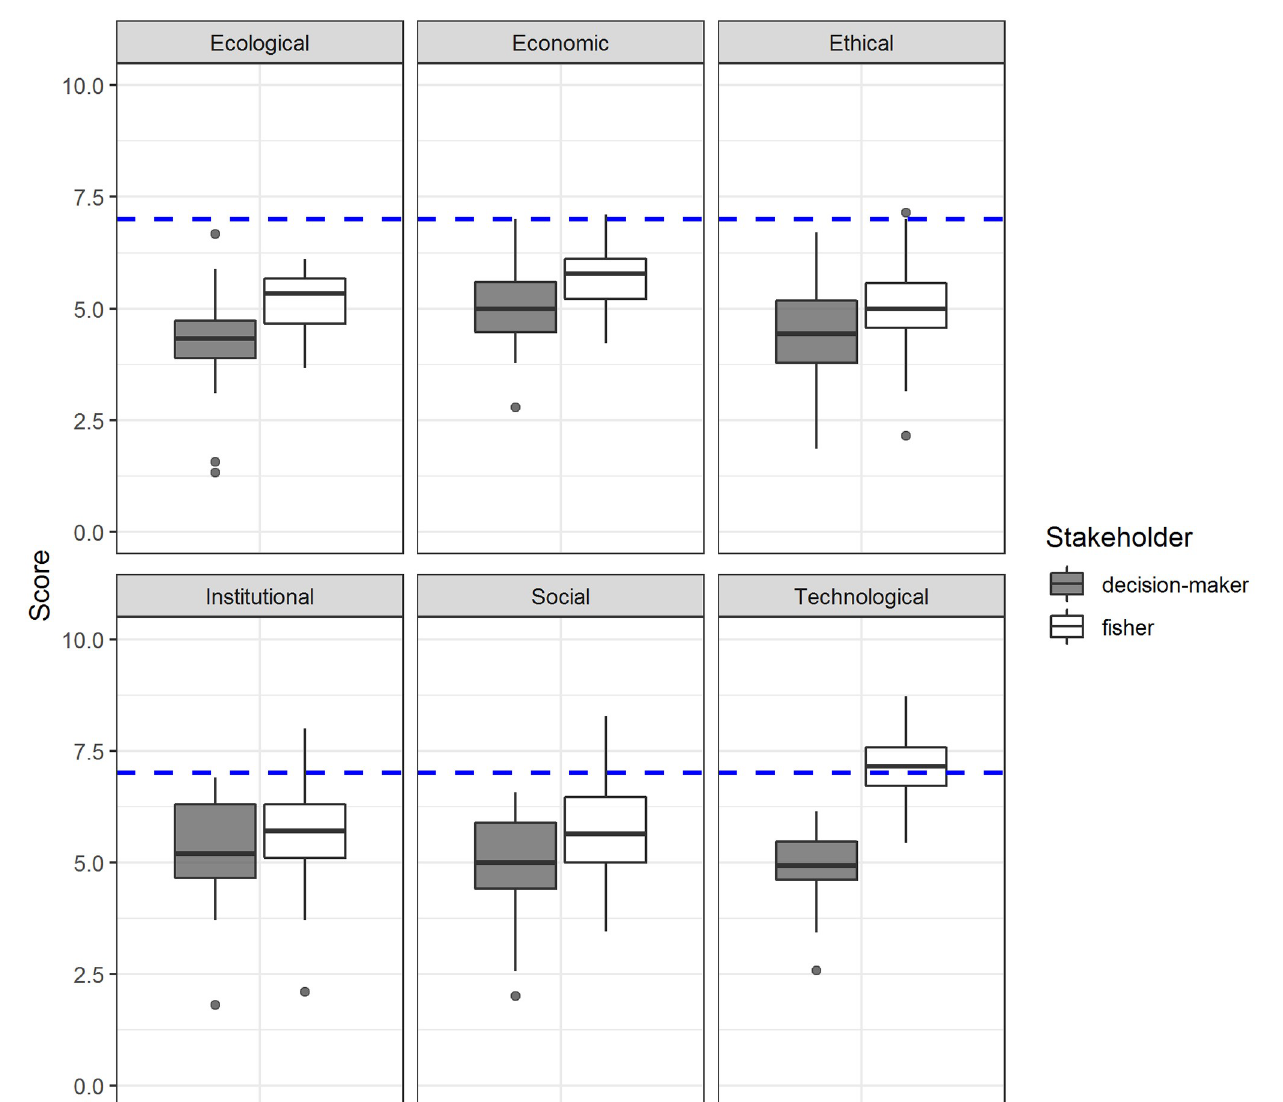
Fig 2. Comparisons of the mean scores between fishers and decision-makers perceptions for the six dimensions. Scoring scale is from zero (worst) to 10 (best), a score of 7/10 indicates a good score (blue dashed line), based on Rapfish (Pitcher et al., 2013).